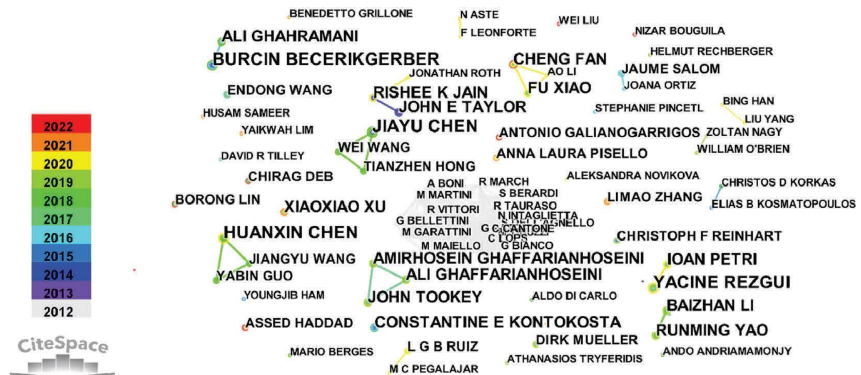
Figure 2: Author collaboration network.